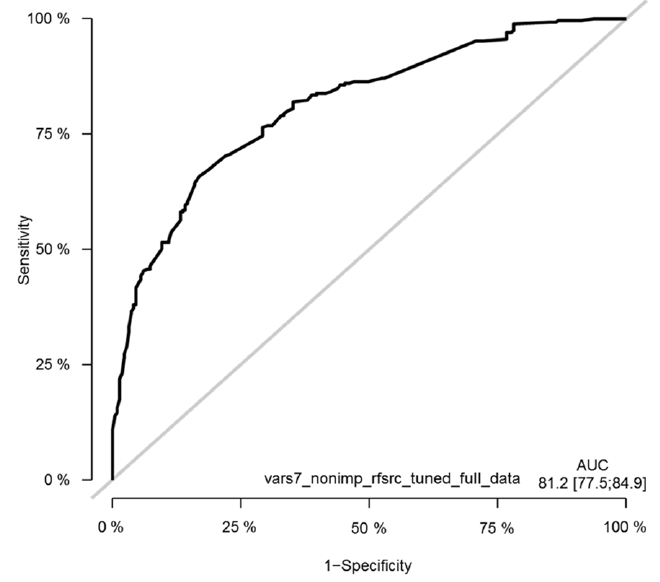
Figure 12. Time-dependent receiver operating characteristic (ROC) curves of the tuned seven-variable SRF model of the melanoma cohort. The ROC curve is shown at the timepoint of 36 months. The y-axis in the plot displays the true positive rate (TPR)—i.e., sensitivity—whereas the x-axis in the plot displays the false positive rate (FPR), i.e., specificity.